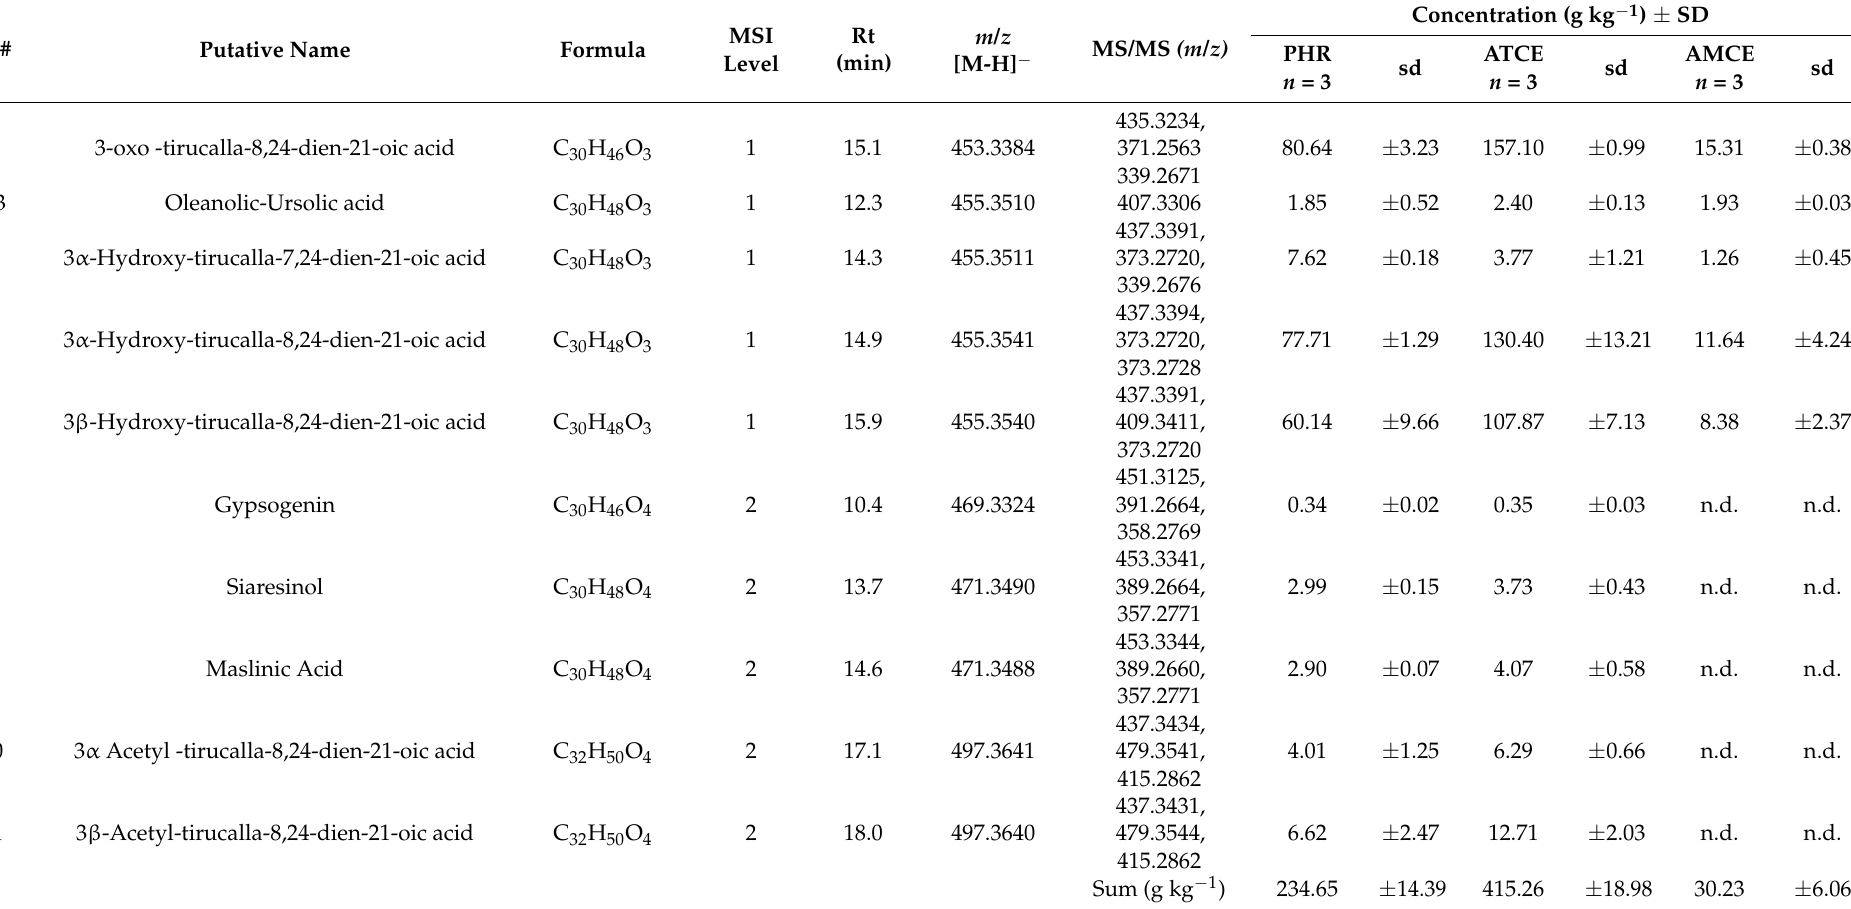
Table 4. Acidic triterpene features annotation and